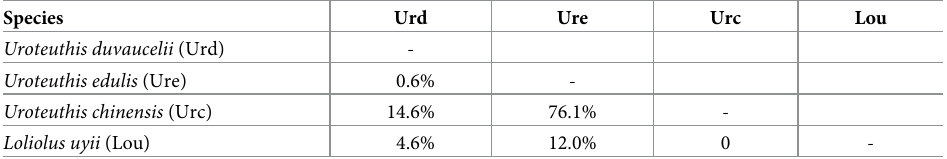
Table 5. Spatial niche overlap (%) among pairs of squid species— Uroteuthis duvaucelii , Uroteuthis edulis , Loliolus uyii , Uroteuthis chinensis in northern South China Sea. Species Urd Ure Urc Lou Uroteuthis duvaucelii (Urd) - Uroteuthis edulis (Ure) 0.6% - Uroteuthis chinensis (Urc) 14.6% 76.1% - Loliolus uyii (Lou) 4.6% 12.0% 0 - Percentages were calculated based on Morisita’s